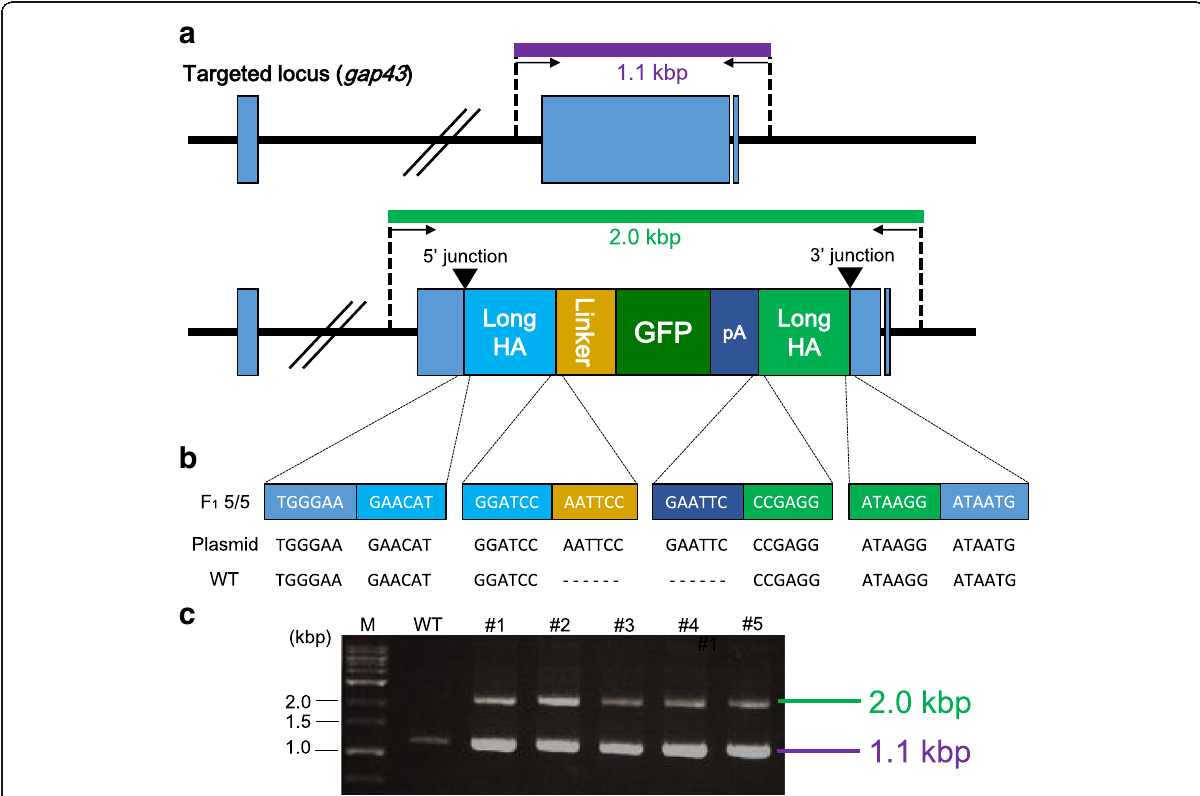
Fig. 4 Precise gene integration of a donor vector containing the GFP gene into the gap43 locus. (a) Schematic illustration of genotyping at the locus. The primer pair (GAP43-for-Seq-Fw and GAP43-for-Seq-Rv) was used for investigating the precise integration into the gap43 loci. The amplicons with or without the insert sequence are 2.0 kbp or 1.1 kbp, respectively. (b) Sequence analysis of the PCR amplicons (2.0 kbp) containing GFP gene. (Upper): Sequence observed in the F 1 fish with the inserted gene (#1 – #5) (Middle): Sequence in the donor plasmid, pBaitD-gap43_500 bp-mAG (Plasmid). (Lower): Sequence in the wild type fish without the insertion (WT). (c) Electrophoresis image of the PCR products. The shorter PCR product (1.1 kbp) amplified from the intact allele was detected in both a wild type (WT) and five F 1 fish with the insertion (#1 – #5). The longer PCR product (2.0 kbp) was detected only in the F 1 fish with the insertion (#1 –